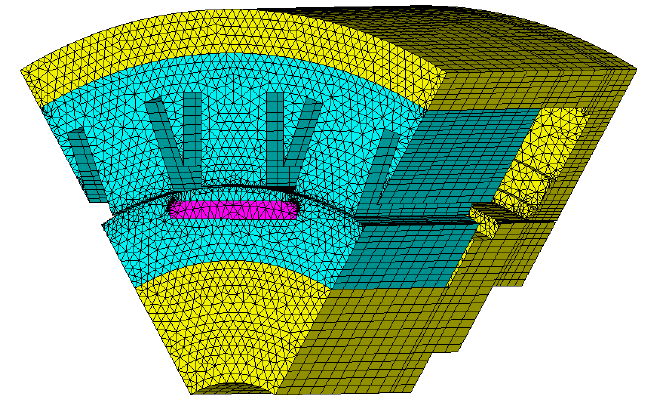
Figure 16. 3D finite element mesh.